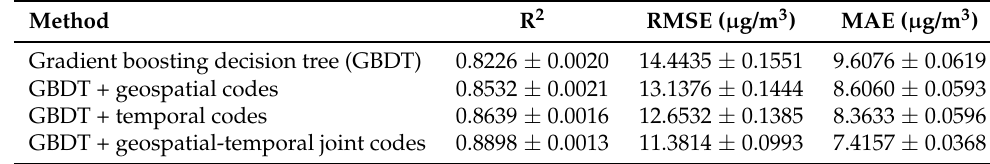
Table 2. The mean and variance of sample-based 10-fold cross-validation results of gradient boosting decision tree (GBDT), GBDT with geospatial codes, GBDT with temporal codes, and GBDT with geospatial-temporal joint